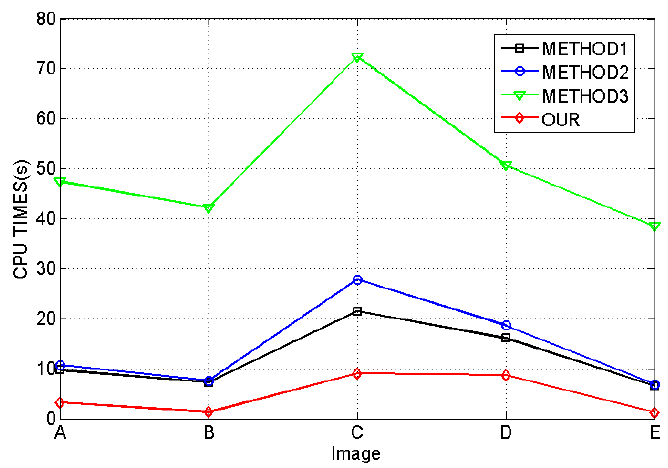
Figure 9. Overview of CPU (central processing unit) times for METHOD1, METHOD2, METHOD3 and our method. Table 2. Comparison of region fitting error (RFE) scores for METHOD1, METHOD2, METHOD3 and our method.